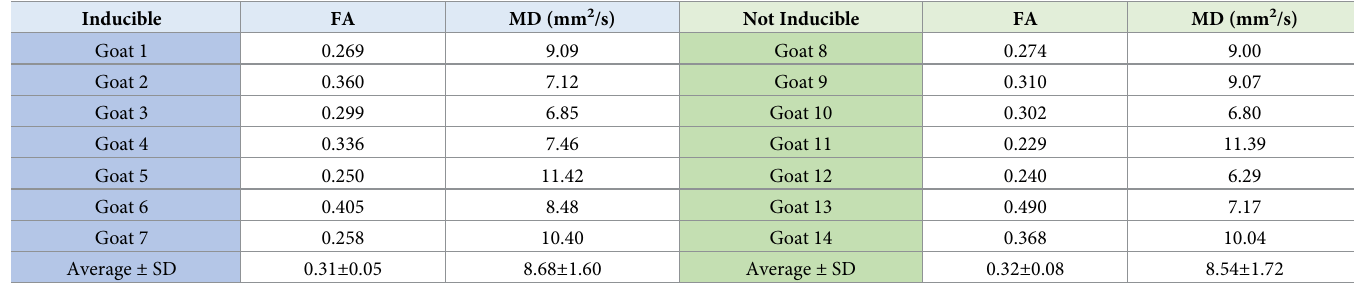
Table 1. Fractional anisotropy (FA) and mean diffusivity (MD) values for all the animals along with the average values for each AF inducibility based group. Inducible FA MD (mm 2 /s) Not Inducible FA MD (mm 2 /s) Goat 1 0.269 Goat 2 0.360